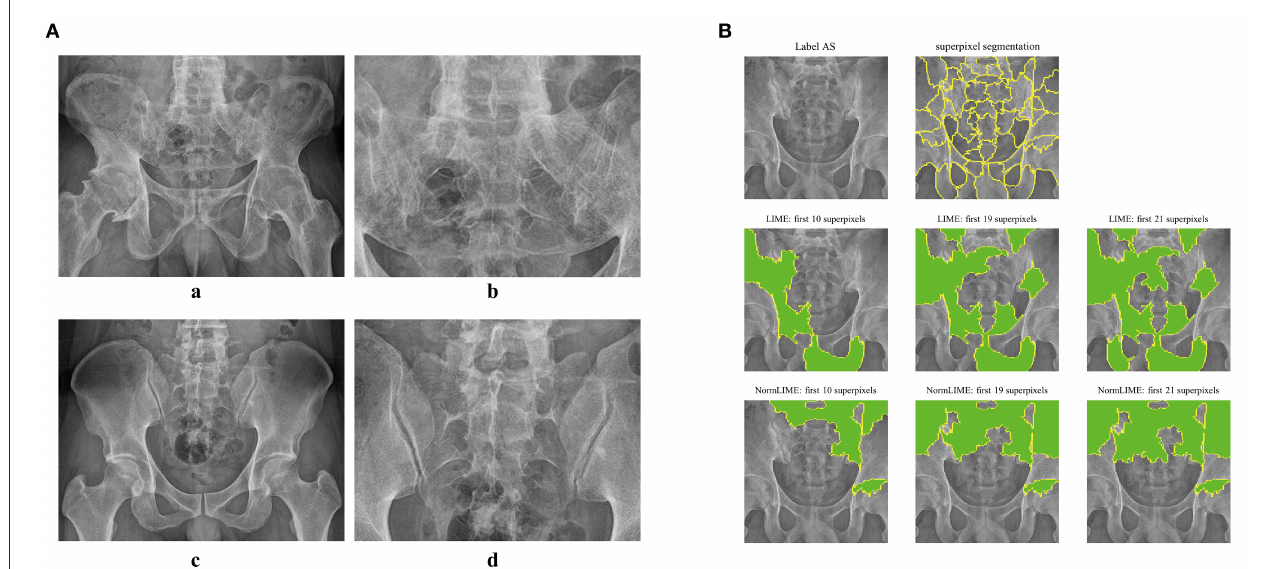
FIGURE3 Example images and interpretative analysis of the ensemble DL model. [ (A) a, b] Example image from a patient with AS. [ (A) c, d] Example image from patient without AS. (B) LIME and NormLIME techniques to visualize the focused areas of interest of the submodel of ensemble DL model.